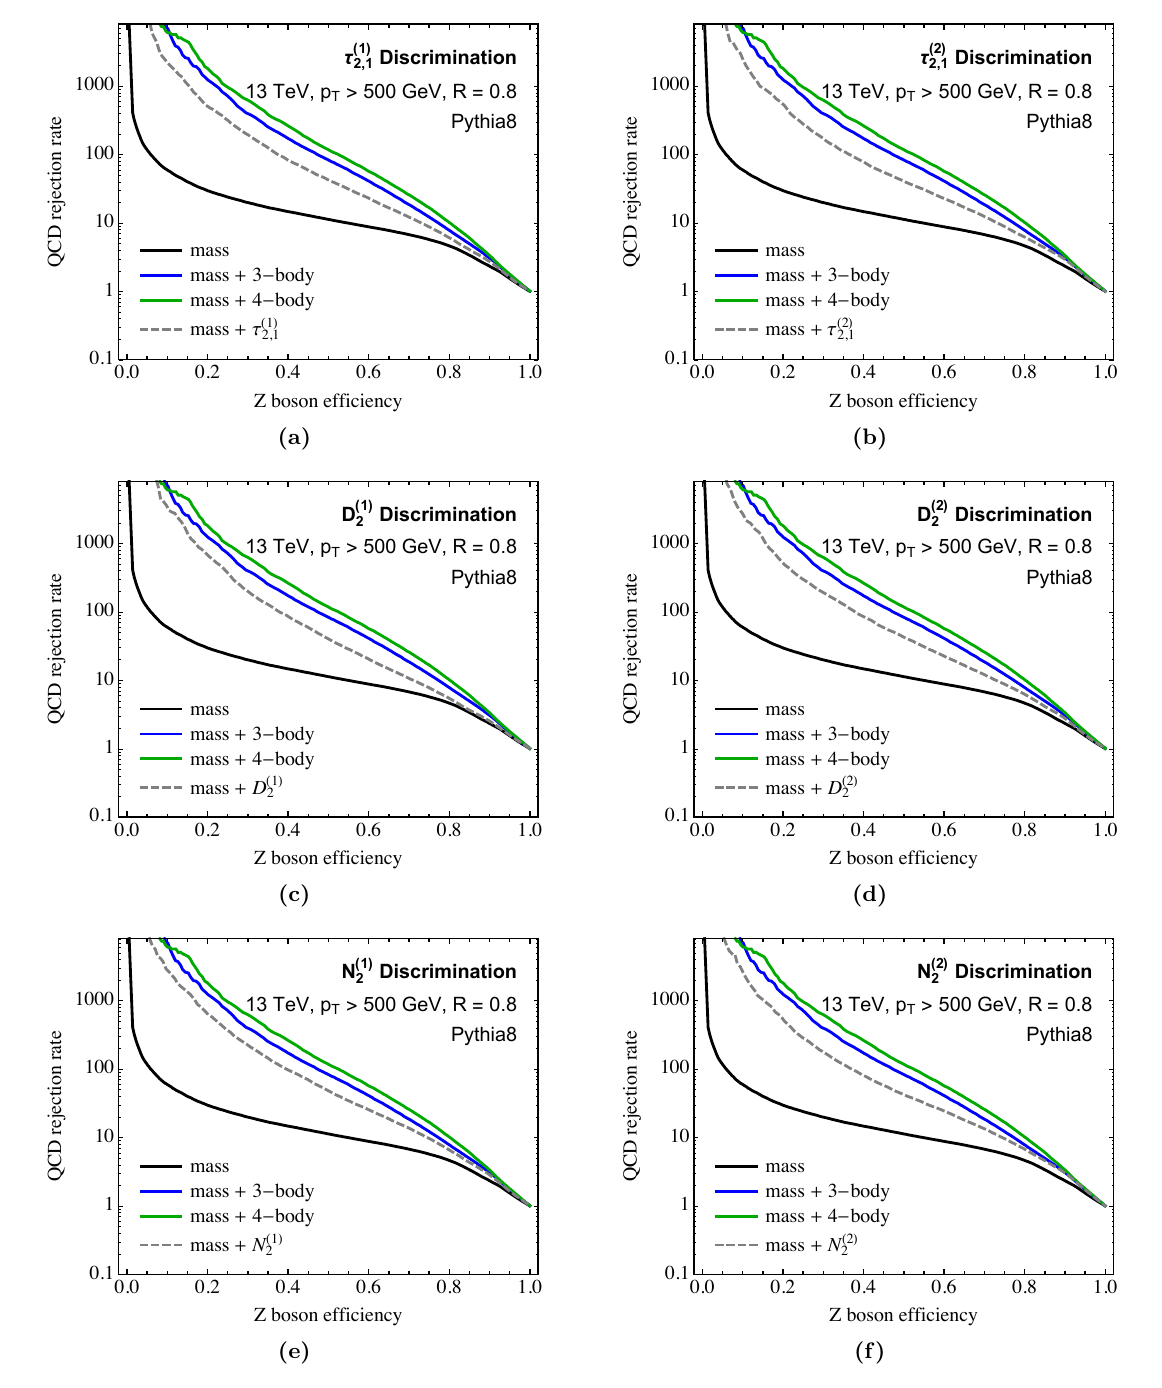
Figure 5. Signal e(cid:14)ciency versus background rejection rate for jet mass plus N -subjettiness ratios (cid:28) (1) (left) and (cid:28) (2) (right), energy correlation function ratios D (1) 2 ; 1 2 ; 1 (left) and N (2) (right), as determined by the neural network. For comparison, we also include the 2 signal e(cid:14)ciency versus background rejection rate for jet mass, jet mass plus 3-body phase space observables, and jet mass plus 4-body phase space observables.